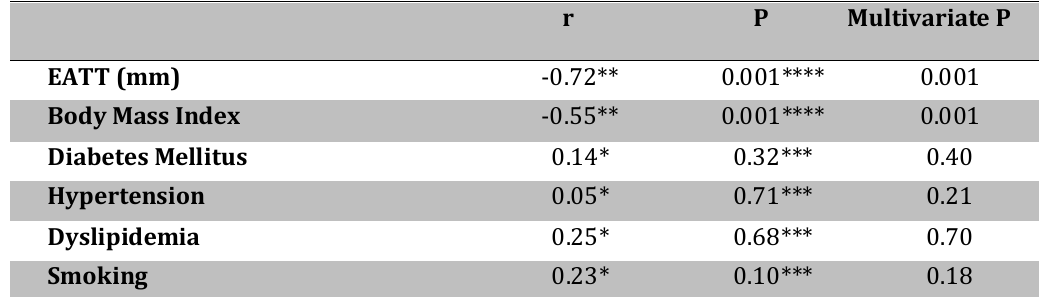
Table 3. Association between Epicardial Adipose Tissue Thickness and Thrombolytic Therapy